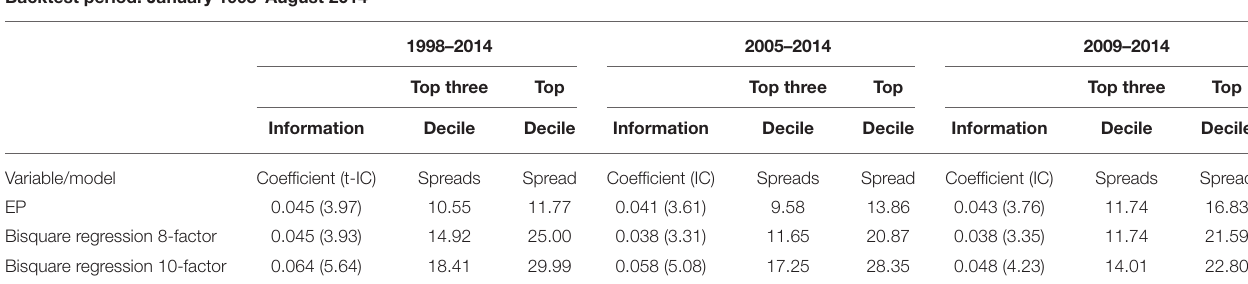
TABLE 1 | Model financial